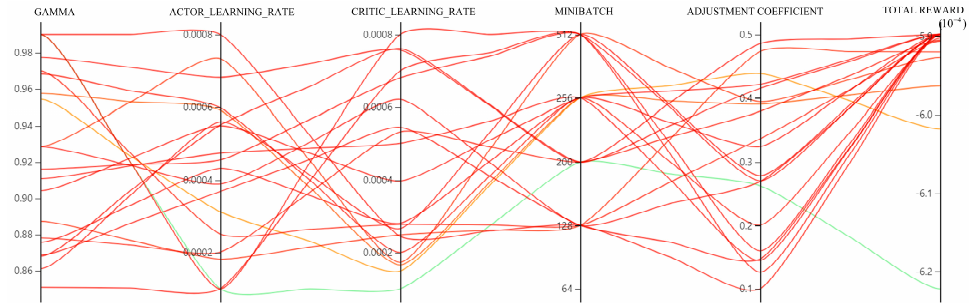
Figure 8. Results of hyperparameter optimization using AutoML.